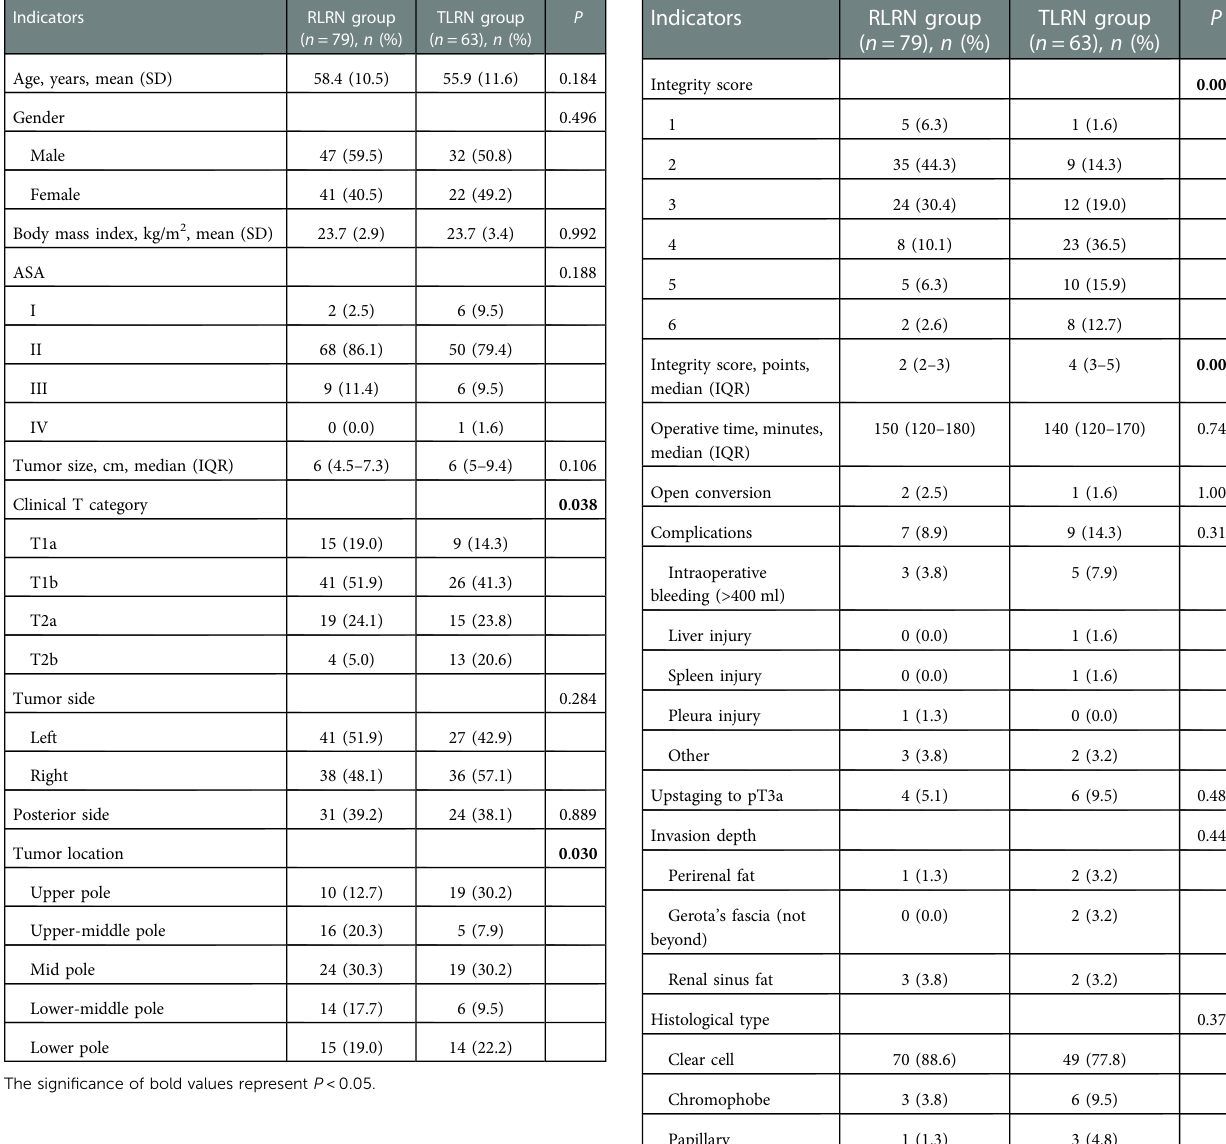
TABLE 2 Perioperative and pathological data of patients who received RLRN or TLRN.